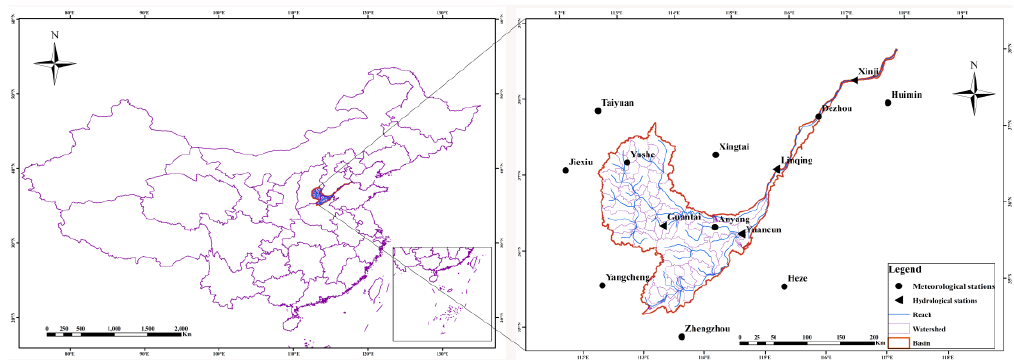
Figure 1. Location and map of the Zhangweinan Canal Basin.